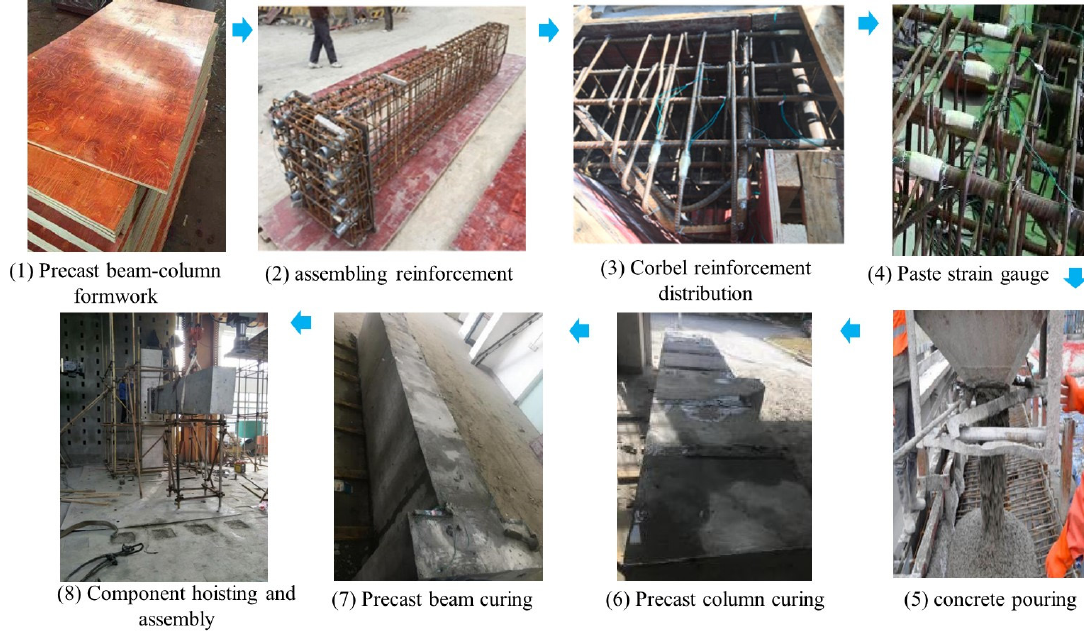
Figure 4. Test specimens’ fabrication process.